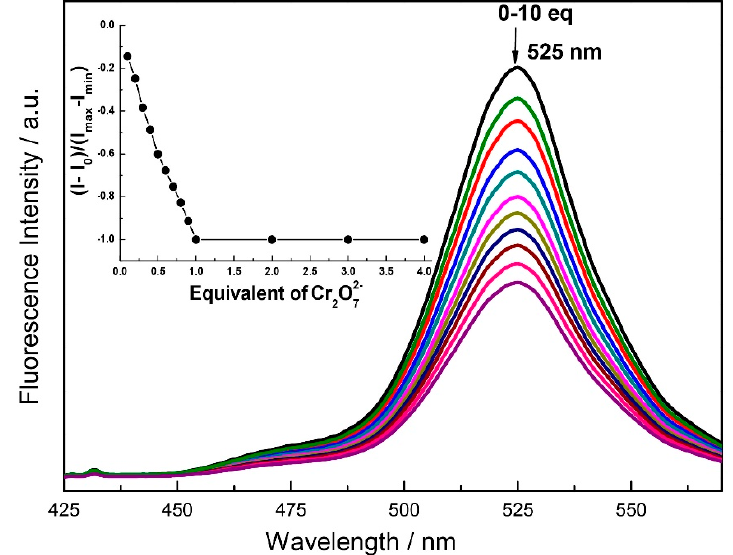
Figure 7. Fluorescence spectra of 2 (1.0 µ M) as a function of added K 2 Cr 2 O 7 (10 µ M) in H 2 O:DMF (9:1) containing HEPES buffer (10 mM, pH 7.4). ( λ ex = 330 nm). Inset: mol ratio plot of emission at 525 nm.